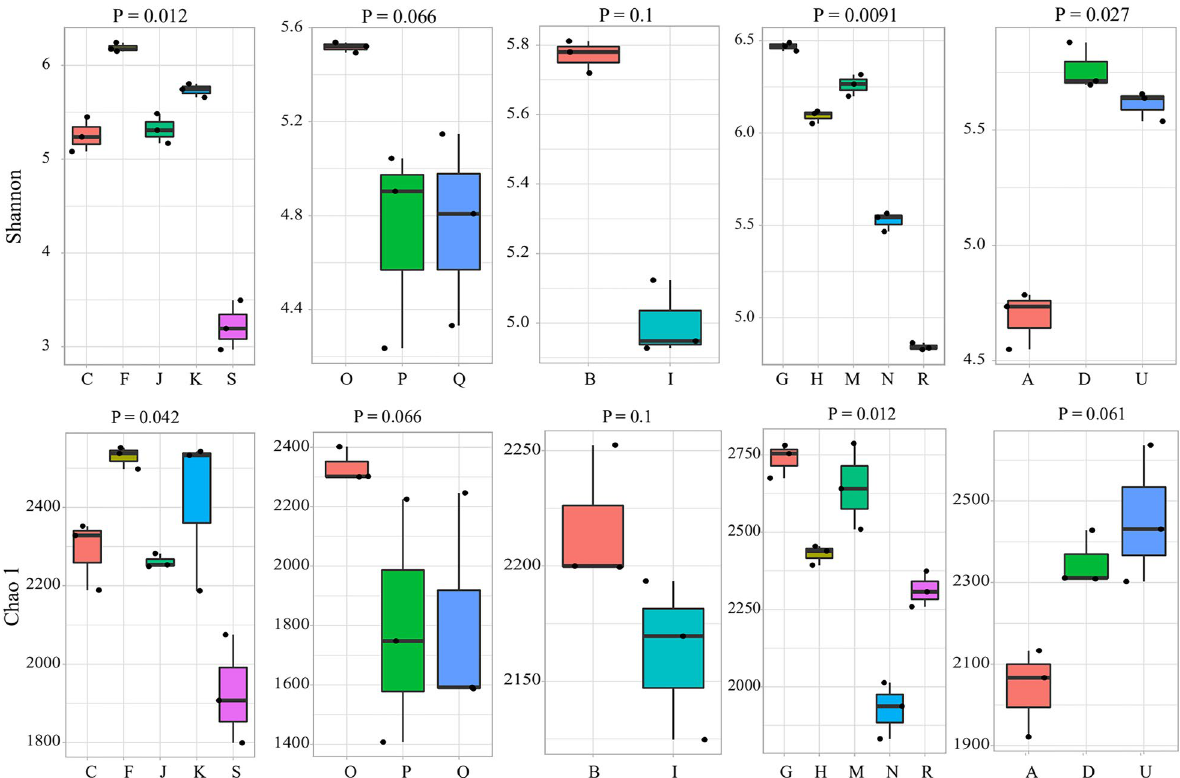
Fig. 5 Alpha diversity indices of bacterial communities within group plant species. Alpha diversity indices include Shannon diversity, Chao 1 richnes. P-value was caculated based on one-way ANOVA with LSD multiple